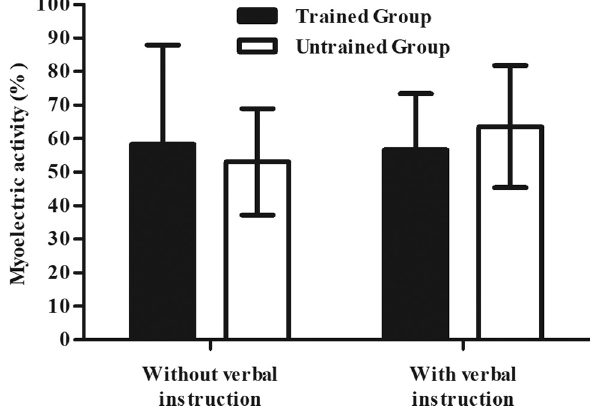
Figure 5 - Myoelectric activity of the posterior deltoid muscle during the seated row at 70% 1RM with and without verbal instructions in trained and untrained